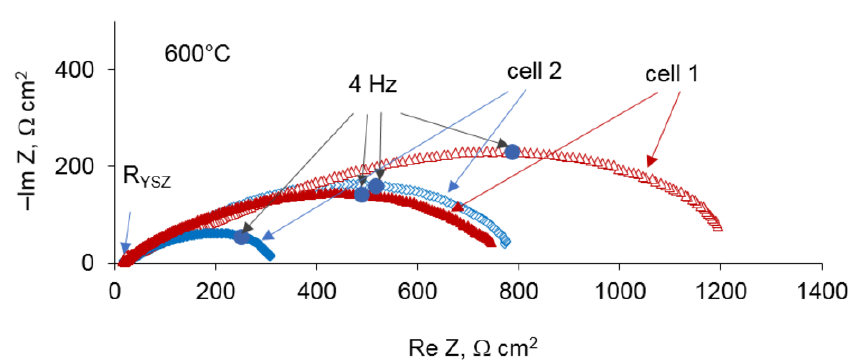
Figure 6. Impedance spectra of cells 1 and 2 before (open symbols) and after (closed symbols) CV testing at 600 °C.